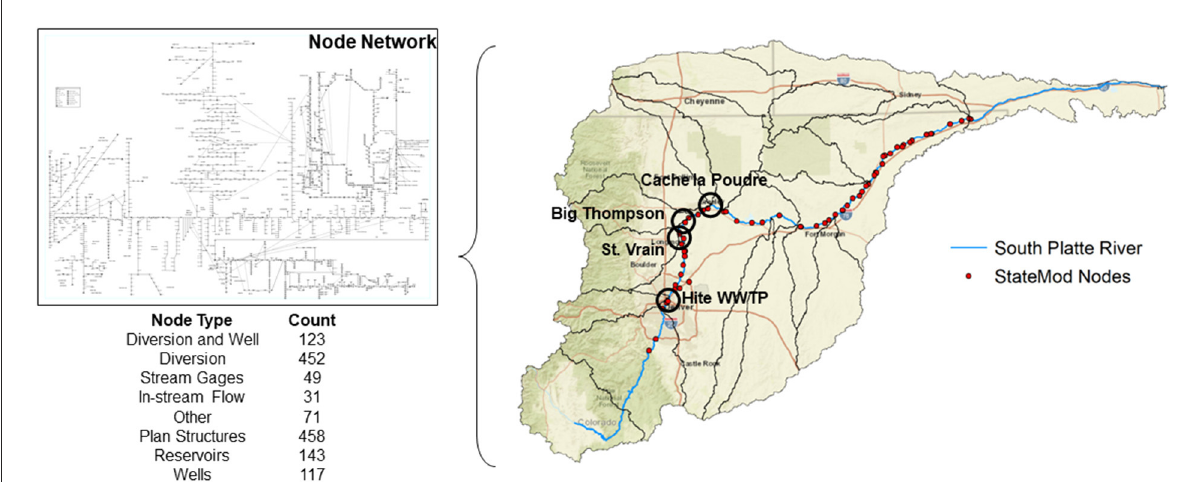
FIGURE3 StateMod (water allocation model) node network, listing the various node types and corresponding nodes (red dots) along the South Platte River (see map on right). Inflow locations of major tributaries are shown on the map, as is the location of the major WWTP (Hite WWTP) in the Denver metro area. The Node Network inset diagram is shown for example, and not for detailed interpretation. Black lines on the map indicate boundaries of watersheds at the 8-digit HUC